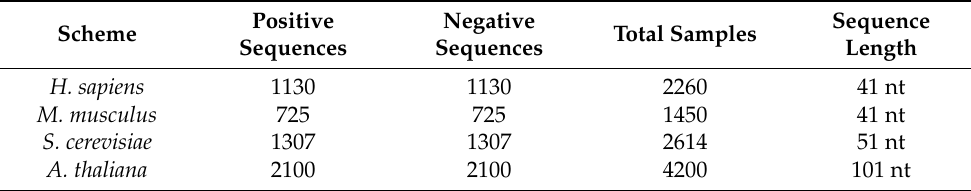
Table 2. Details pertaining to four species of benchmark datasets.